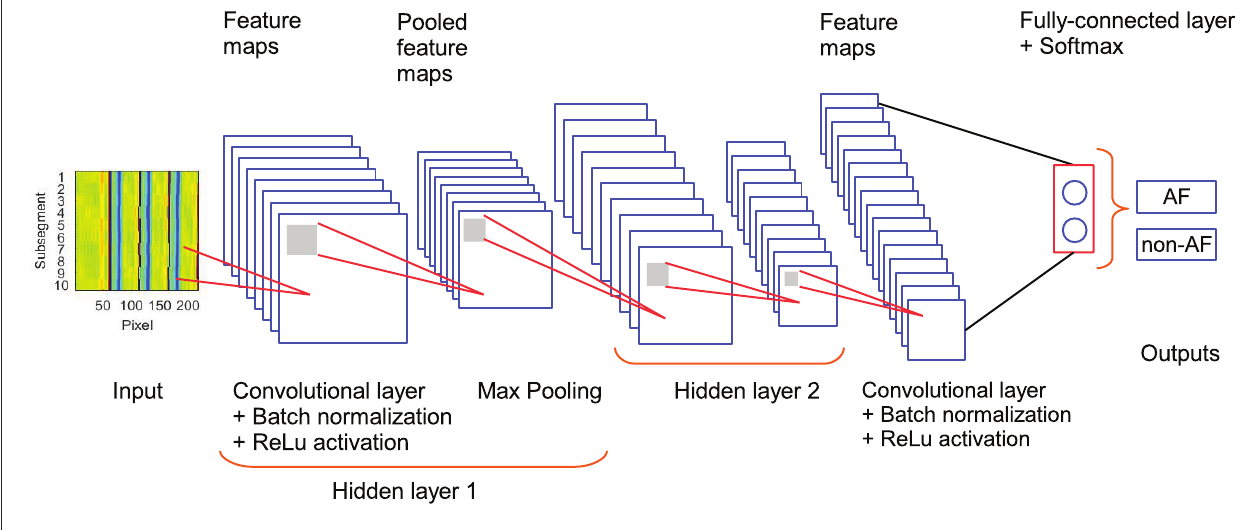
FIGURE 2 | Architecture of the CNN used in the study. Hidden layer 2 contains the same set of elements as hidden layer 1.